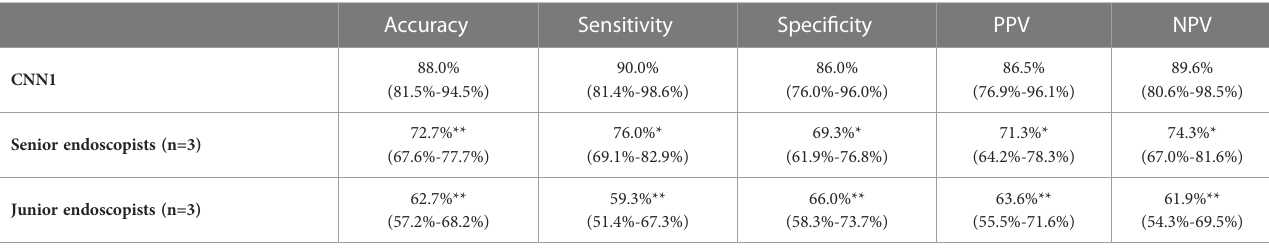
TABLE 3 Comparison between CNN1 and endoscopists in the diagnosis of